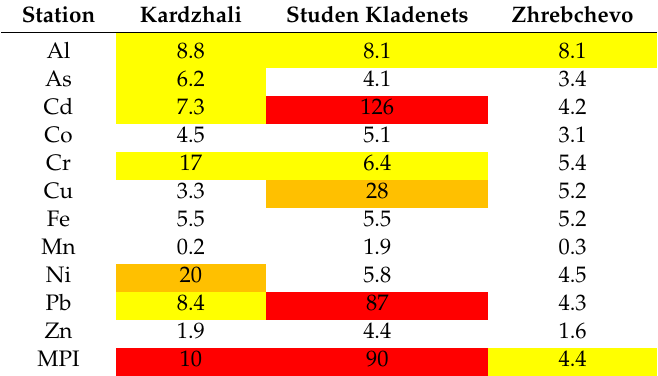
Table 2. Contamination factors for 11 elements in moss-bags, and metal pollution index (MPI) at the studied stations. Legend: yellow: certain / moderate pollution; orange: strong pollution; red: extreme / heavy pollution (following ranges of contamination factors and metal pollution index as in Material and Methods). Station Kardzhali Studen Kladenets